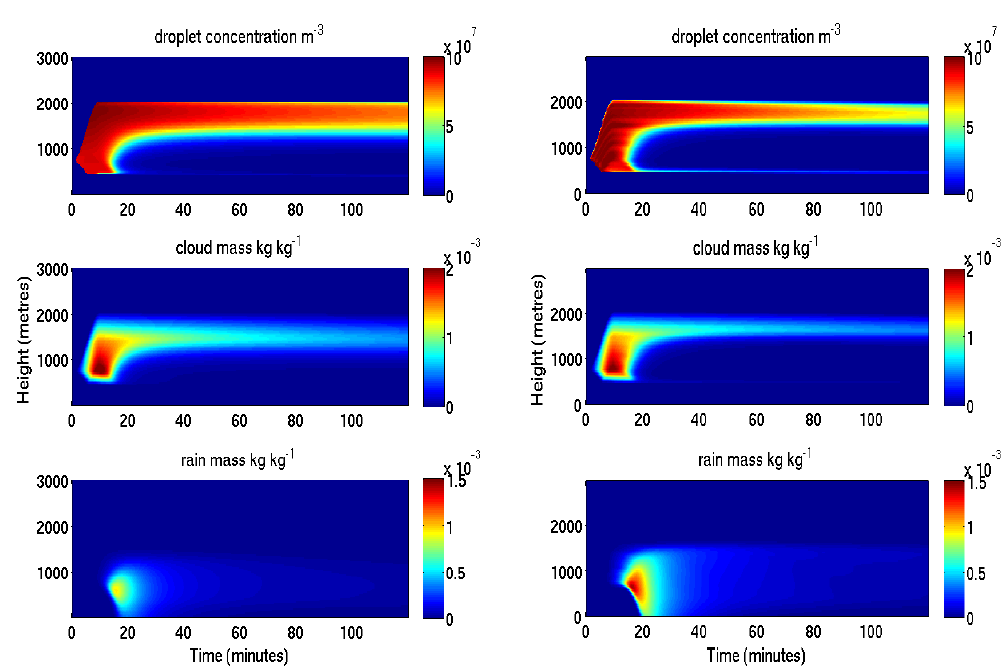
Fig. 4. Comparison of cloud droplet number concentration (m − 3 ), cloud mass mixing ratio (kg kg − 1 ) and rain mixing ratio (kg kg − 1 ) from the 2-m A-R scheme (left) and the bin scheme (right). The results shown are taken from simulations with w 1 =2 ms − 1 , T =RICO and CCN=100/cc.